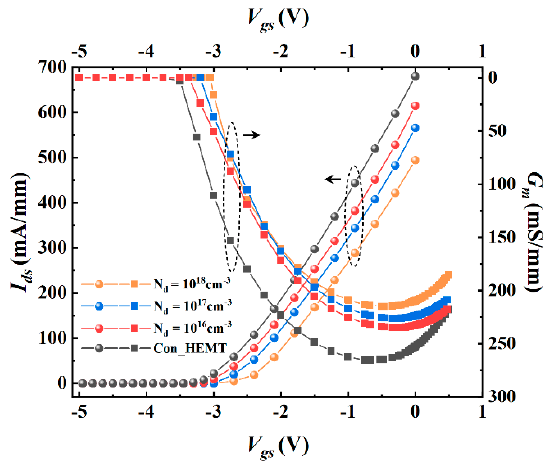
Figure 4. I ds − V gs and G m − V gs of the proposed structure with different doping concentration.